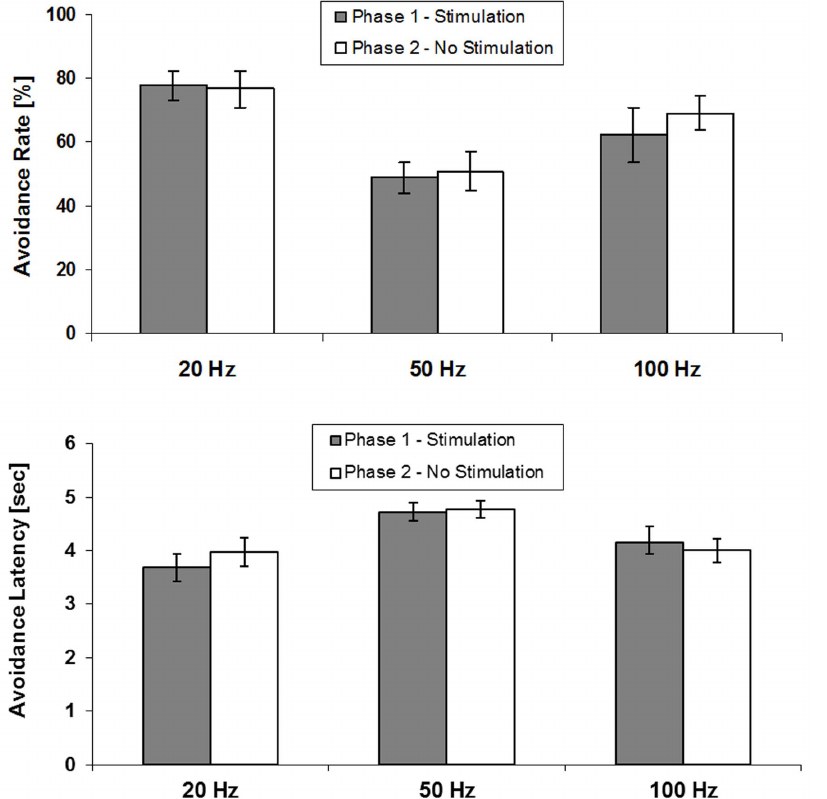
Figure 4. Mean ± SEM of percentage of avoidance rate and avoidance latency in session 5 with LHb stimulation and in session 10 after 5 additional training sessions without